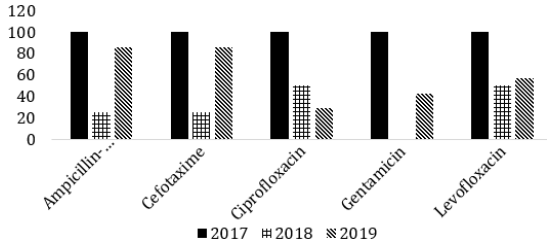
Figure 1. The pattern of antibiotic resistance in